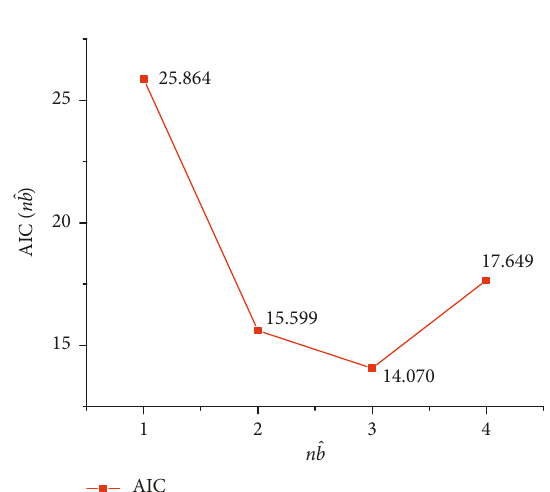
Figure 2: Order of the nonlinear block using FOE.